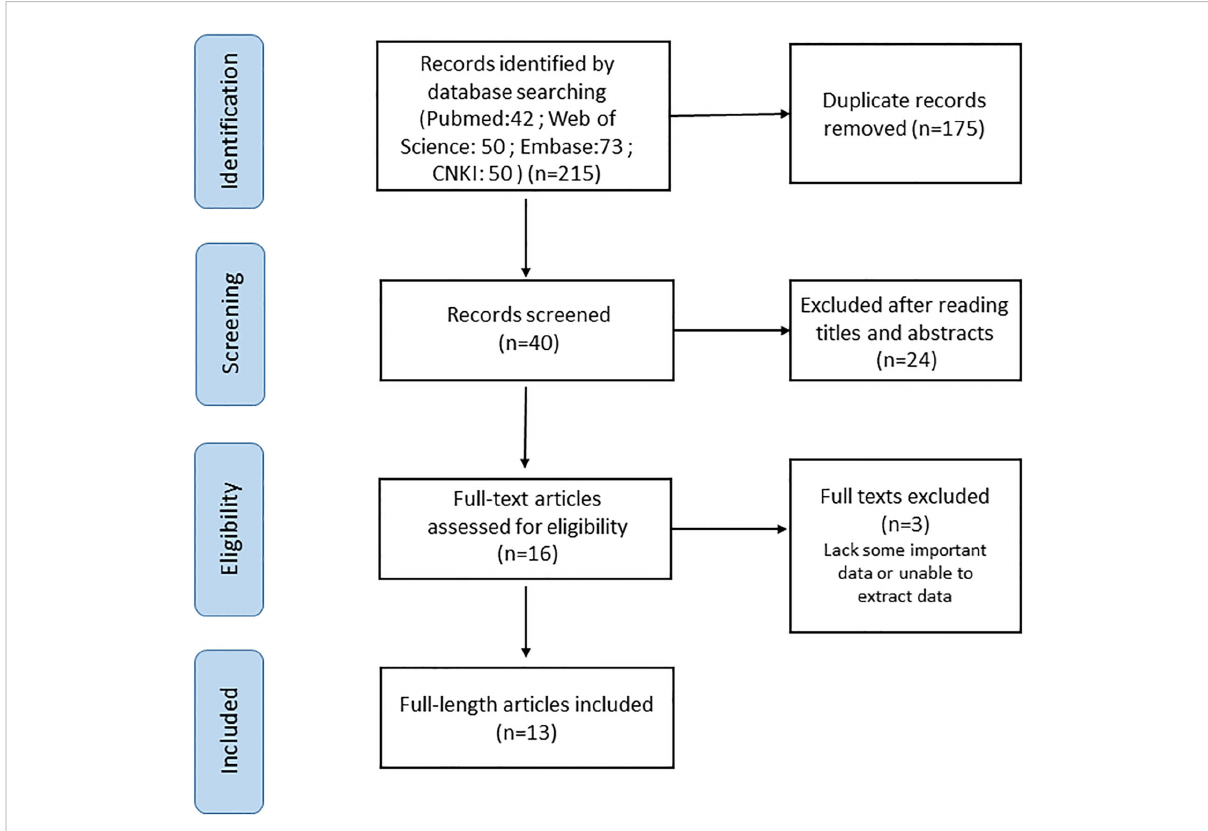
FIGURE 1 Flow chart of the selection of studies in the